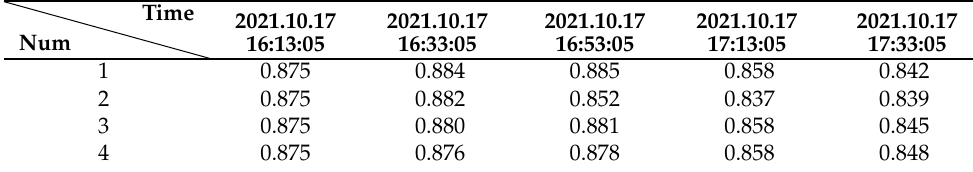
Table 2. After normalization of deformation data.